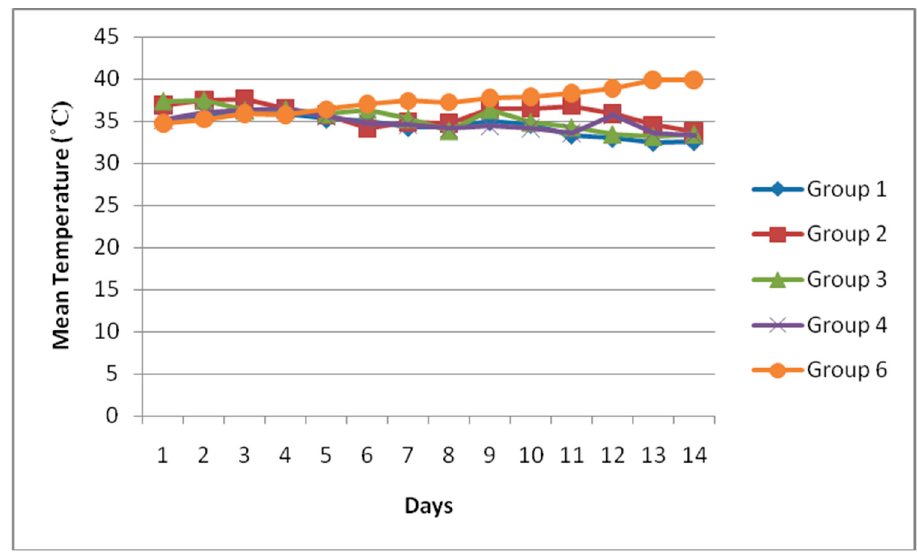
Figure 2. Mean ( n = 2) temperature of the experimental animals within 14 days.